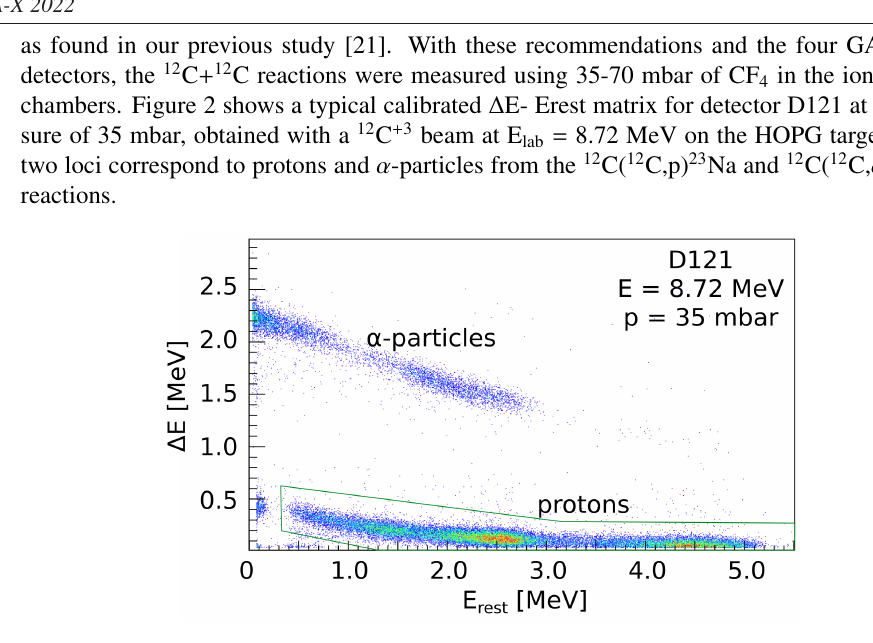
Figure 2. Typical calibrated ∆ E - Erest matrix showing the α particles and protons loci. This matrix was obtained using D121 with 35 mbar of CF 4 in the IC and with a E lab = 8.72 MeV 12 C + 3 beam impinging on the HOPG target. Figure taken from [20] (published under a Creative Commons Attribution 4.0 International